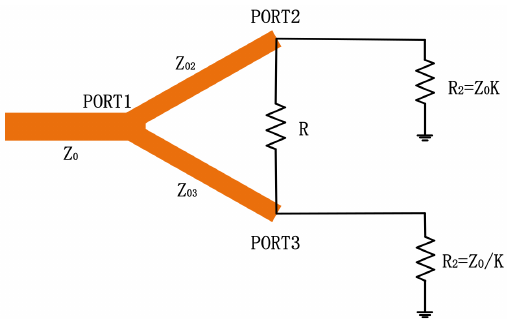
Figure 8. Schematic diagram of the 2:1 Wilkinson power